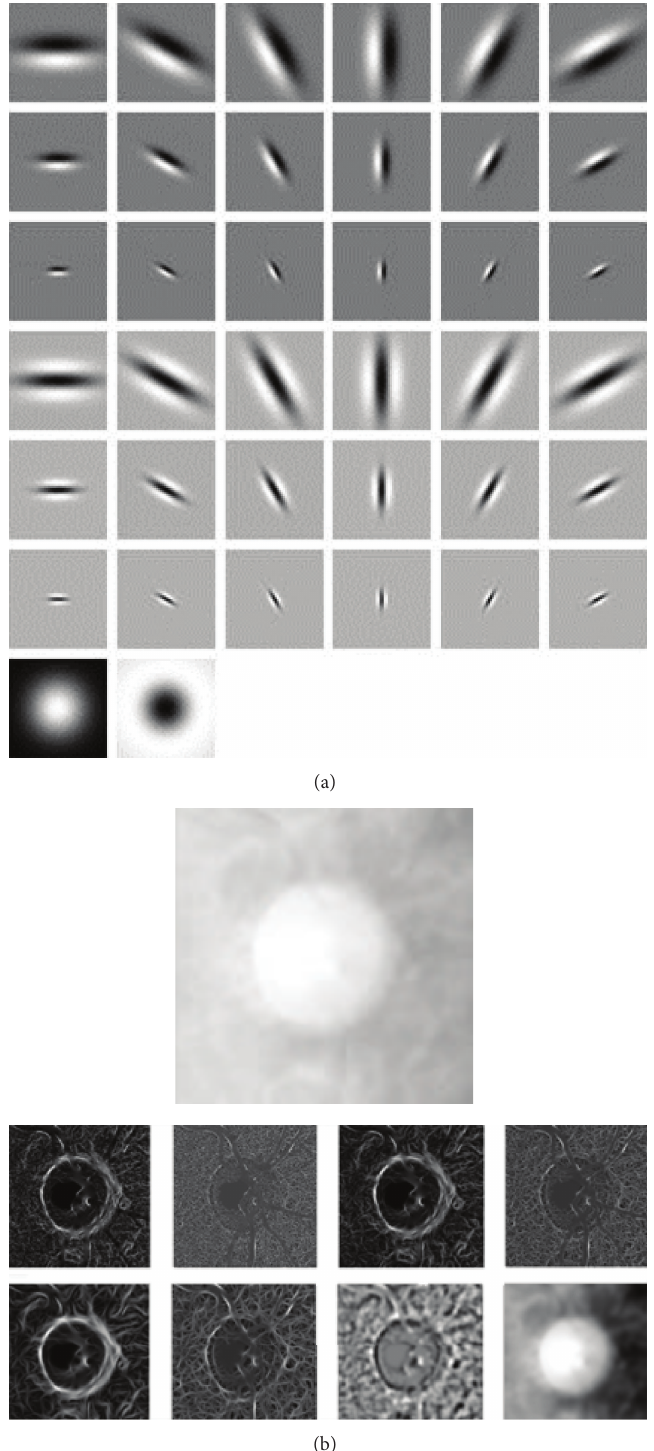
Figure 6: Root Filter Set and MR8 filter results. (a) Root Filter Set. (b) The upper part is the raw image. The lower part is the response result from MR8